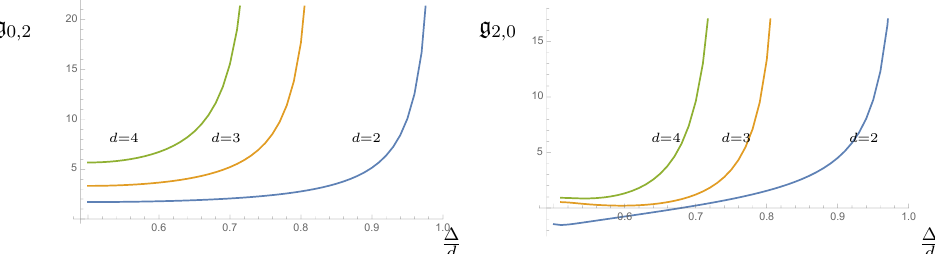
Figure 4 . The numerical values of the quantities g 0 ; 2 and i g 2 ; 0 as a function of the conformal dimension (cid:1) in dimensions 2, 3, and 4, respectively. We have con(cid:12)ned attention to the case of relevant operators (cid:1) 2 ( d ; d + 1) when the integrals are convergent without need of additional 2 2